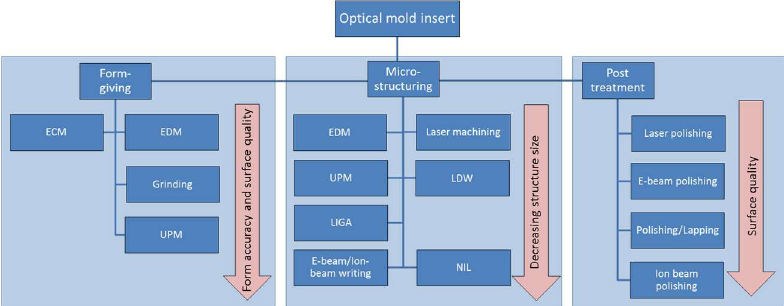
Figure 15. Available technologies for form-giving machining, micro-structuring and post-treatment.